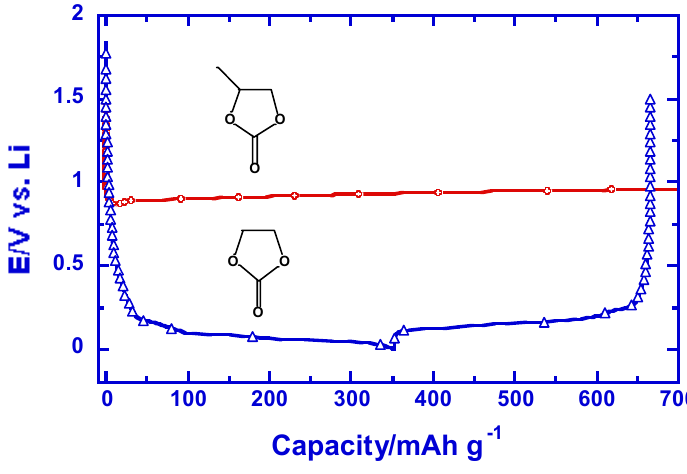
Figure 3. The difference in interphasial chemistry caused by a methyl group might be responsible for the four decade postponement of Li ion technology: voltage profiles of graphitic anodes in LiPF /EC and LiPF /PC during polarization to 0.002 V vs. Li 6 6 (reproduced with permission from The Electrochemical Society).